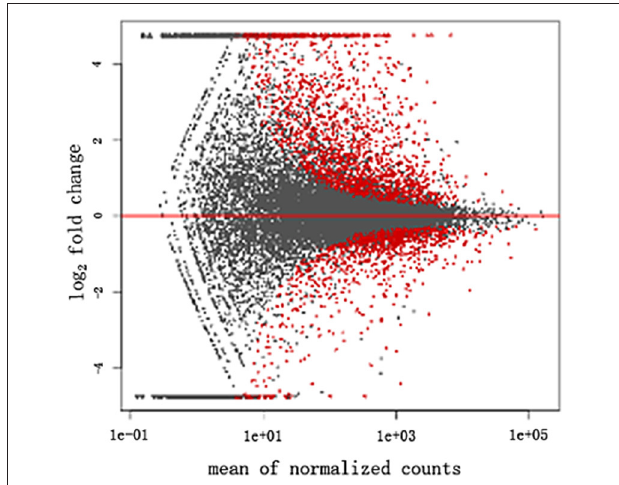
FIGURE 1 | Volcano plot of the differentially displayed genes in tomato.